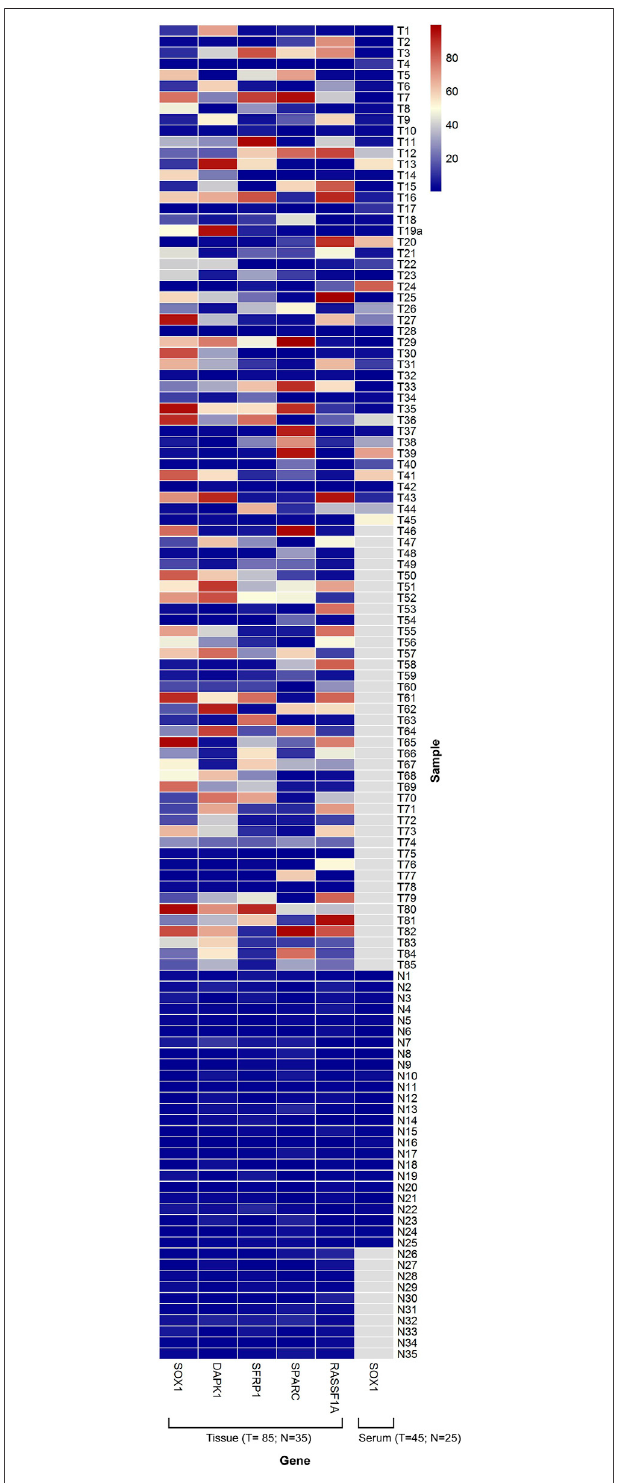
FIGURE 2 | Heat map showing distribution of PMR values for the candidate biomarker genes SOX1, DAPK1, SFRP1, SPARC and RASSF1A. Representations of Methylation level of candidate genes in tissue DNA (85 EOC/35 Control) and in serum cell free DNA (45 EOC/25 Control). The